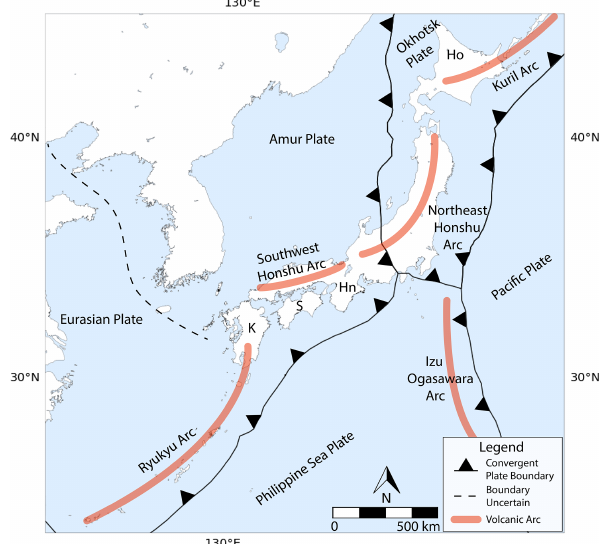
Figure 1. Modified from Taira (2001). An overview of the tectonic plates that compose and surround the Japanese archipelago, detail- ing the interactions between the Okhotsk, Amura, Eurasian, Pacific, and Philippine sea plates; their plate boundaries; and the resulting volcanic arcs. Names of the major islands of Japan are abbreviated: Ho: Hokkaido; Hn: Honshu; S: Shikoku; K: